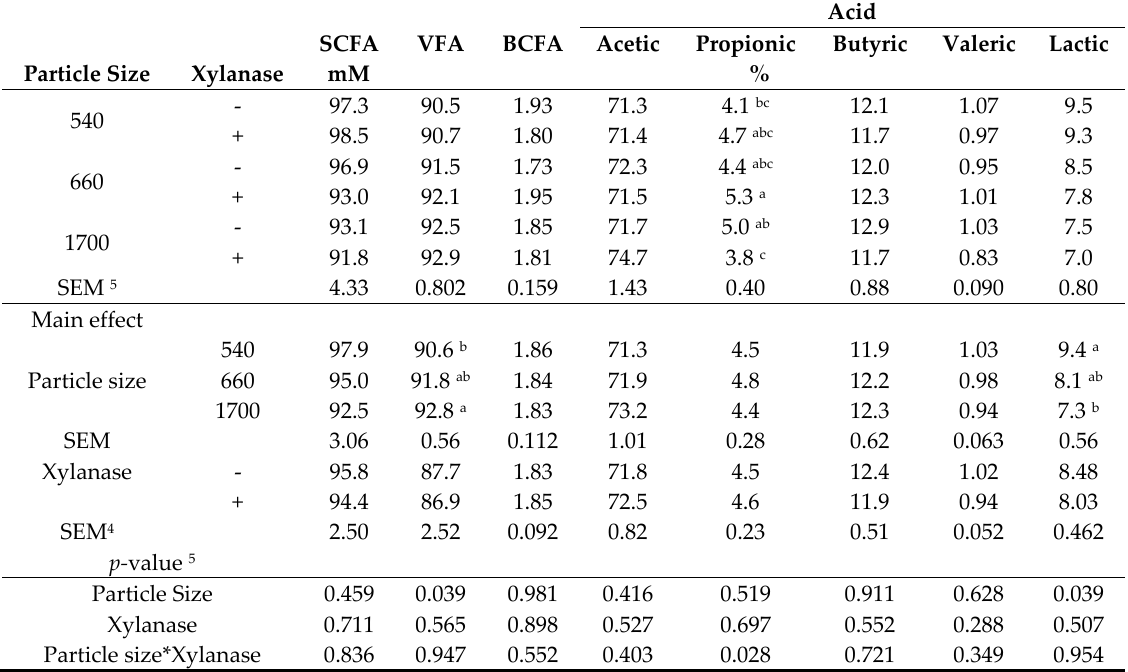
Table 10. Effect of particle size 1 and xylanase inclusion on total short-chain fatty acid 2,3